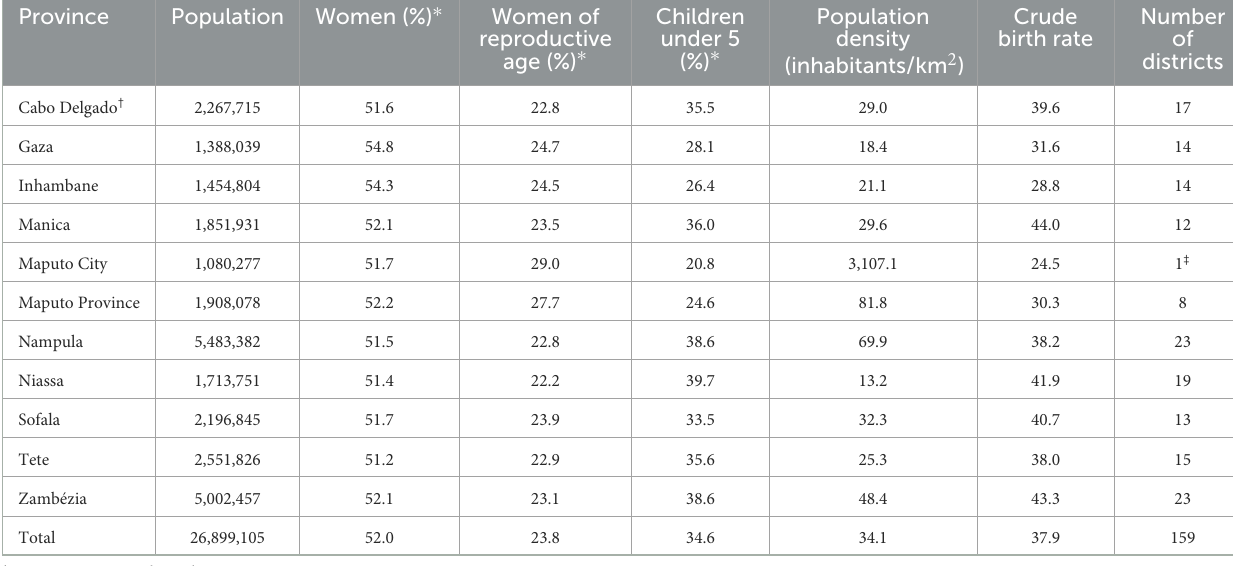
TABLE 1 Mozambique demographic characteristics by